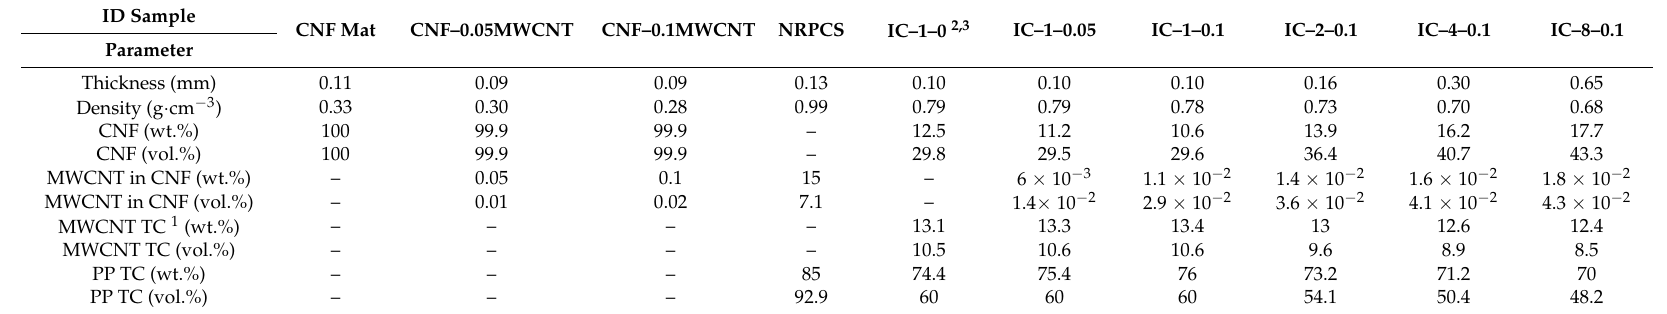
Table 1. General characteristics of the developed